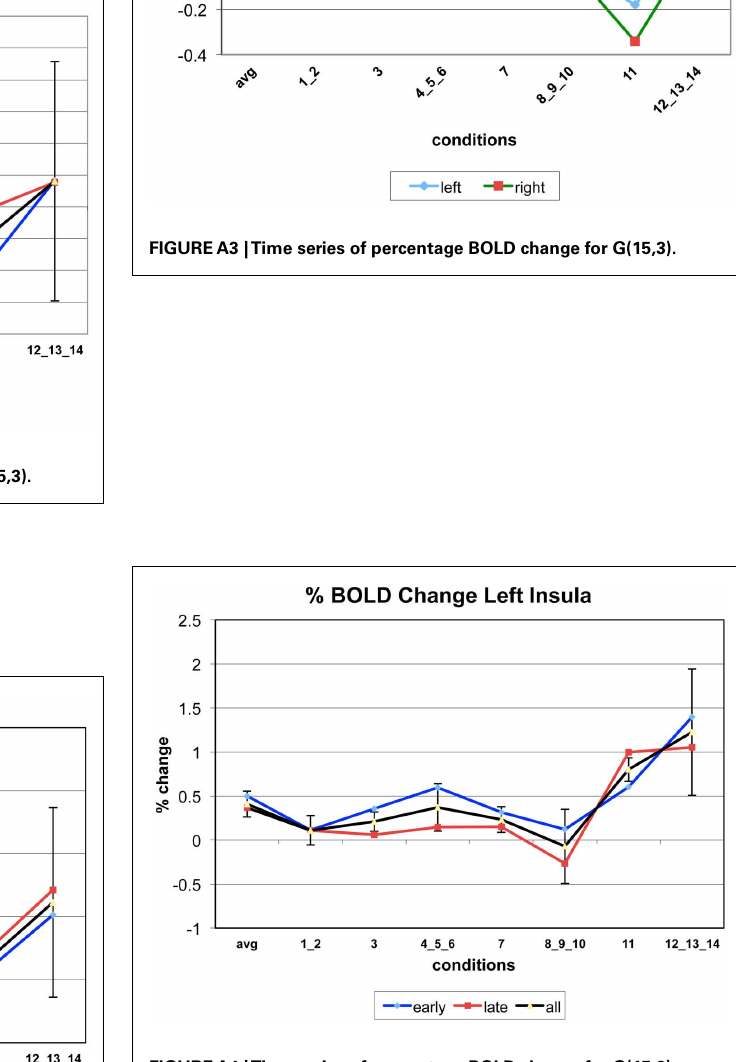
FIGUREA4 |Time series of percentage BOLD change for